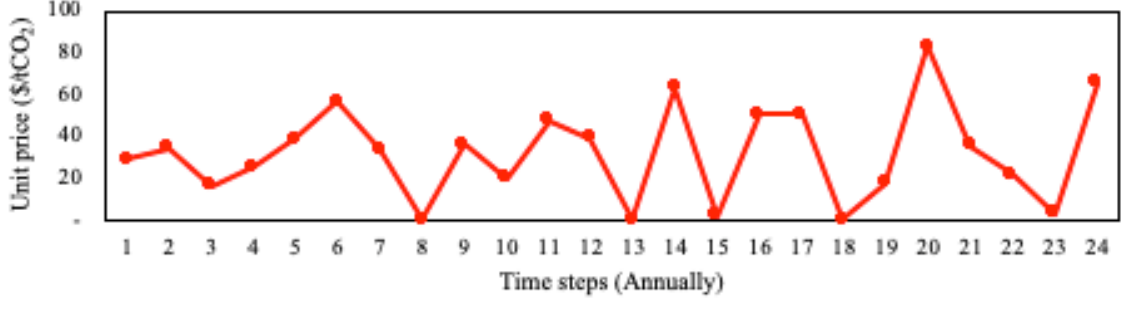
Figure 7. A single realisation of CO 2 price simulation.